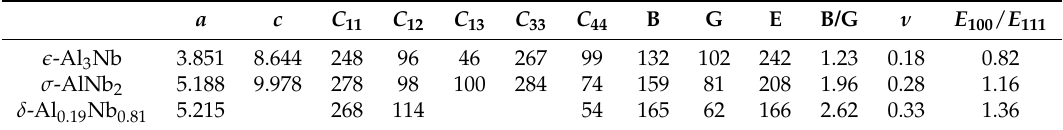
Table 1. Lattice parameters of (cid:101) -Al 3 Nb, σ -AlNb 2 , and the ordered δ -Al 0.19 Nb 0.81 together with the corresponding elastic constants ( C ij in GPa), the polycrystalline bulk ( B in GPa), shear ( G in GPa) and Youngs’s moduli ( E in GPa). The B / G and the Poisson’s ratio ( ν ) represent ductility estimates, while the E 100 / E 111 ratio between the Young’s moduli in the (100) and (111) direction relates to elastic isotropy. a σ -AlNb